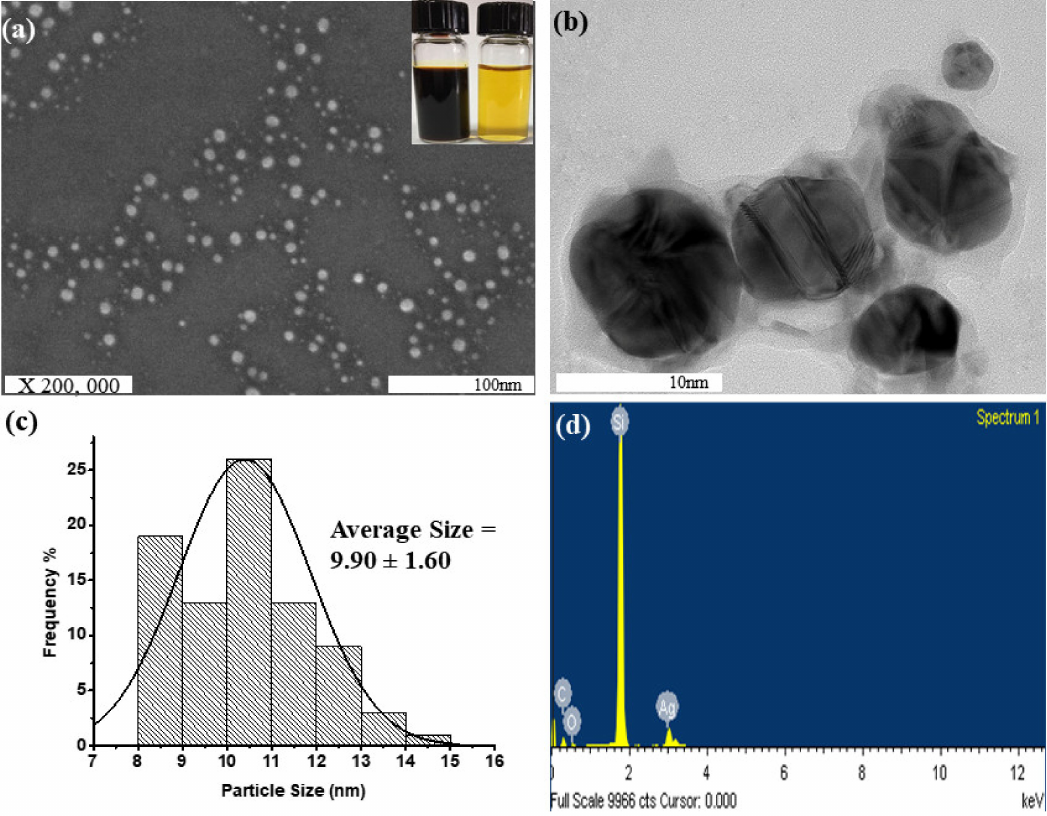
Figure 3. ( a ) SEM image of nearly monodispersed Ag NPs-PTA, (inset is the optical images of concentrated (left) and diluted (right) colloidal dispersion of Ag NPs-PTA); ( b ) HR-TEM image of nanoparticles; ( c ) Size distribution analysis of Ag NPs-PTA; and ( d ) EDS pattern of synthesized Ag NPs-PTA.